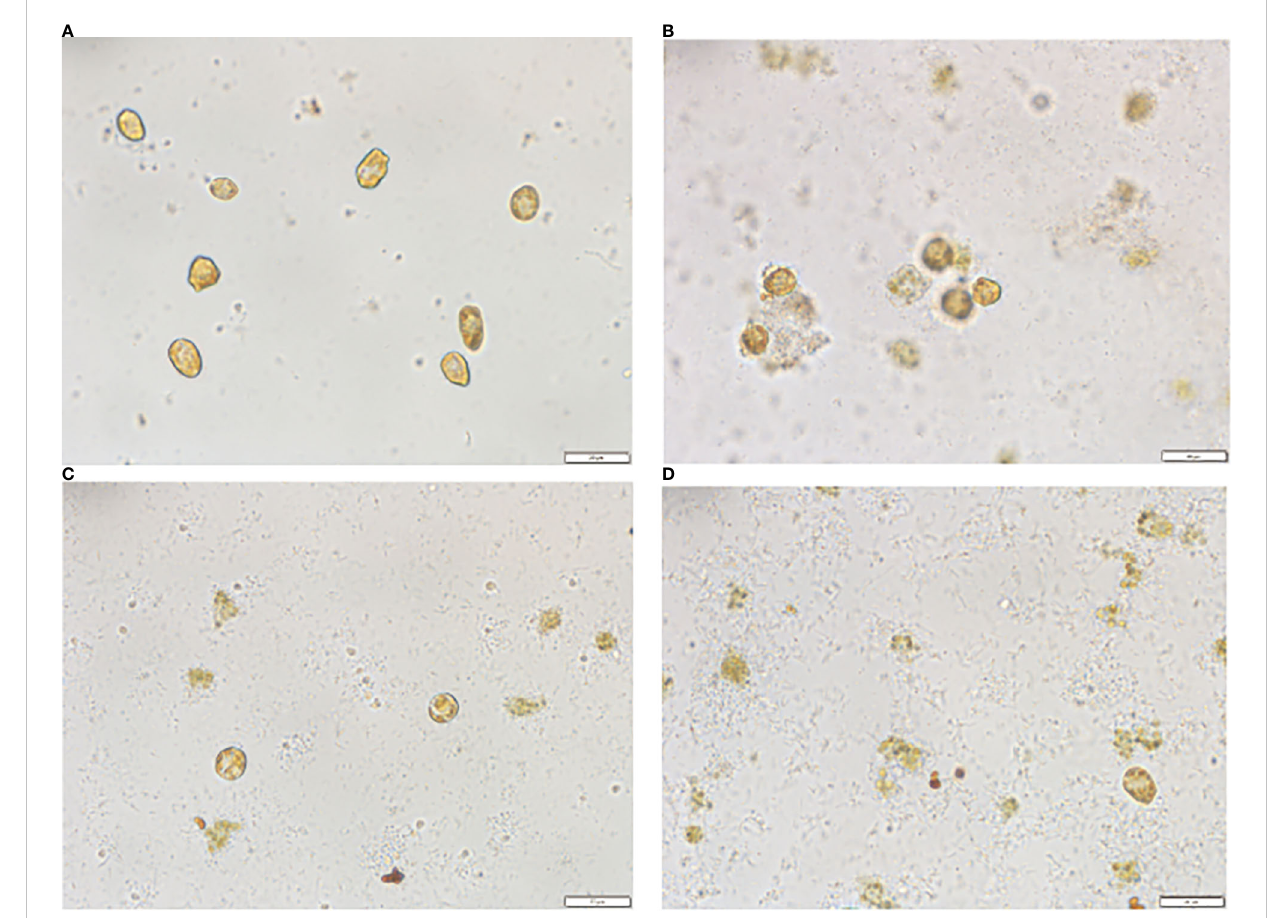
FIGURE 4 Morphological changes in Heterosigma akashiwo treated with algicidal substances observed by light microscopy after 0h (A) , 0.5h (B) , 4h (C) and 24h (D)